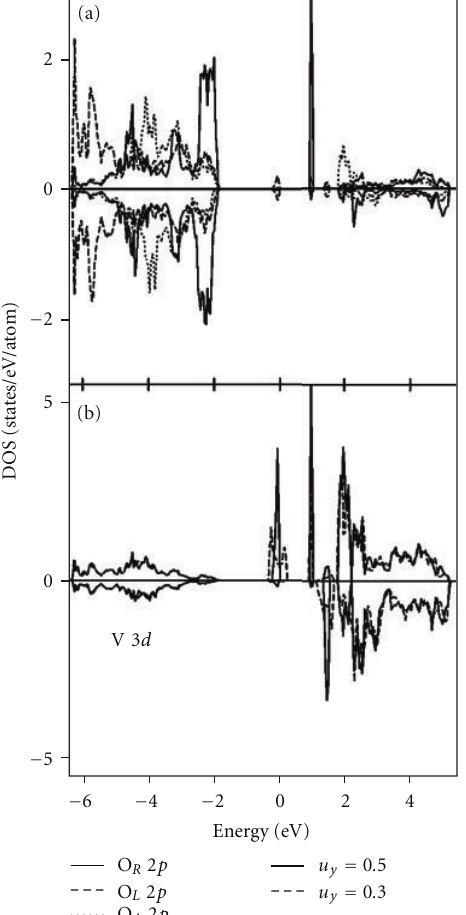
Figure 33: Spin-projected densities of the 2 p states of the three inequivalent oxygen atoms (a) and the V 3 d states (b) in α (cid:2) -NaV 2 O 5 calculated for U e ff = 3eV and AFM order of V magnetic moments along the b direction. For comparison the densities of the V 3 d states calculated for u y = 0 . 3 are also shown by dashed lines in (b). All energies are given relative to the valence-band maximum [249].